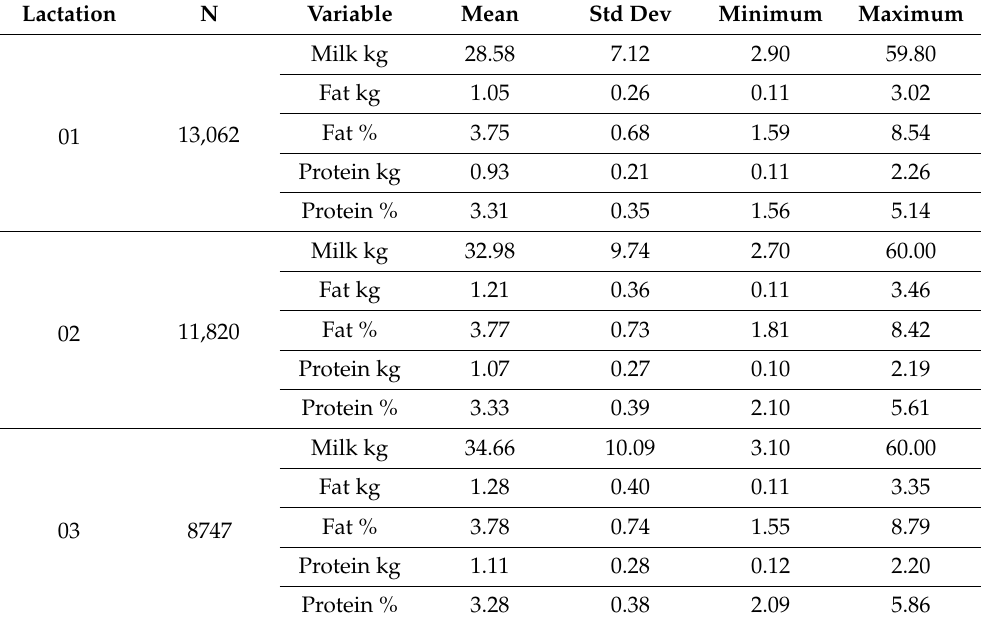
Table 7. Descriptive statistics for the milk variables in the first three lactations (test day